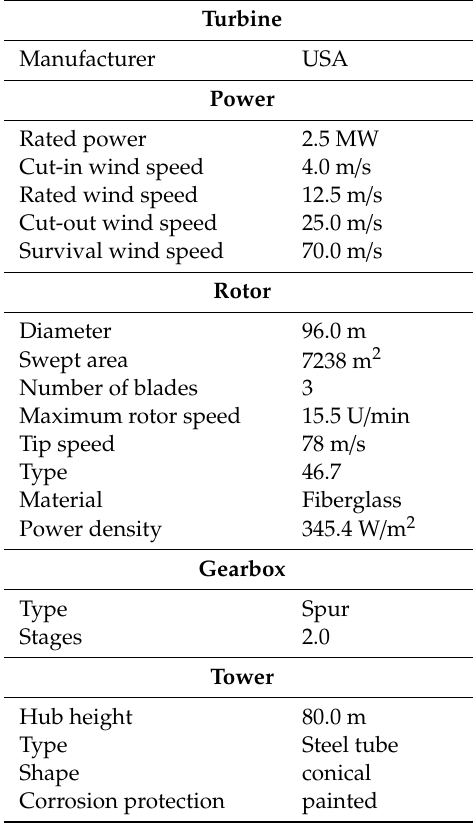
Figure 2. Curves of Rayleigh distribution for all months. Table 2. Manufacturer information of a C96–2.5 MW wind turbine.